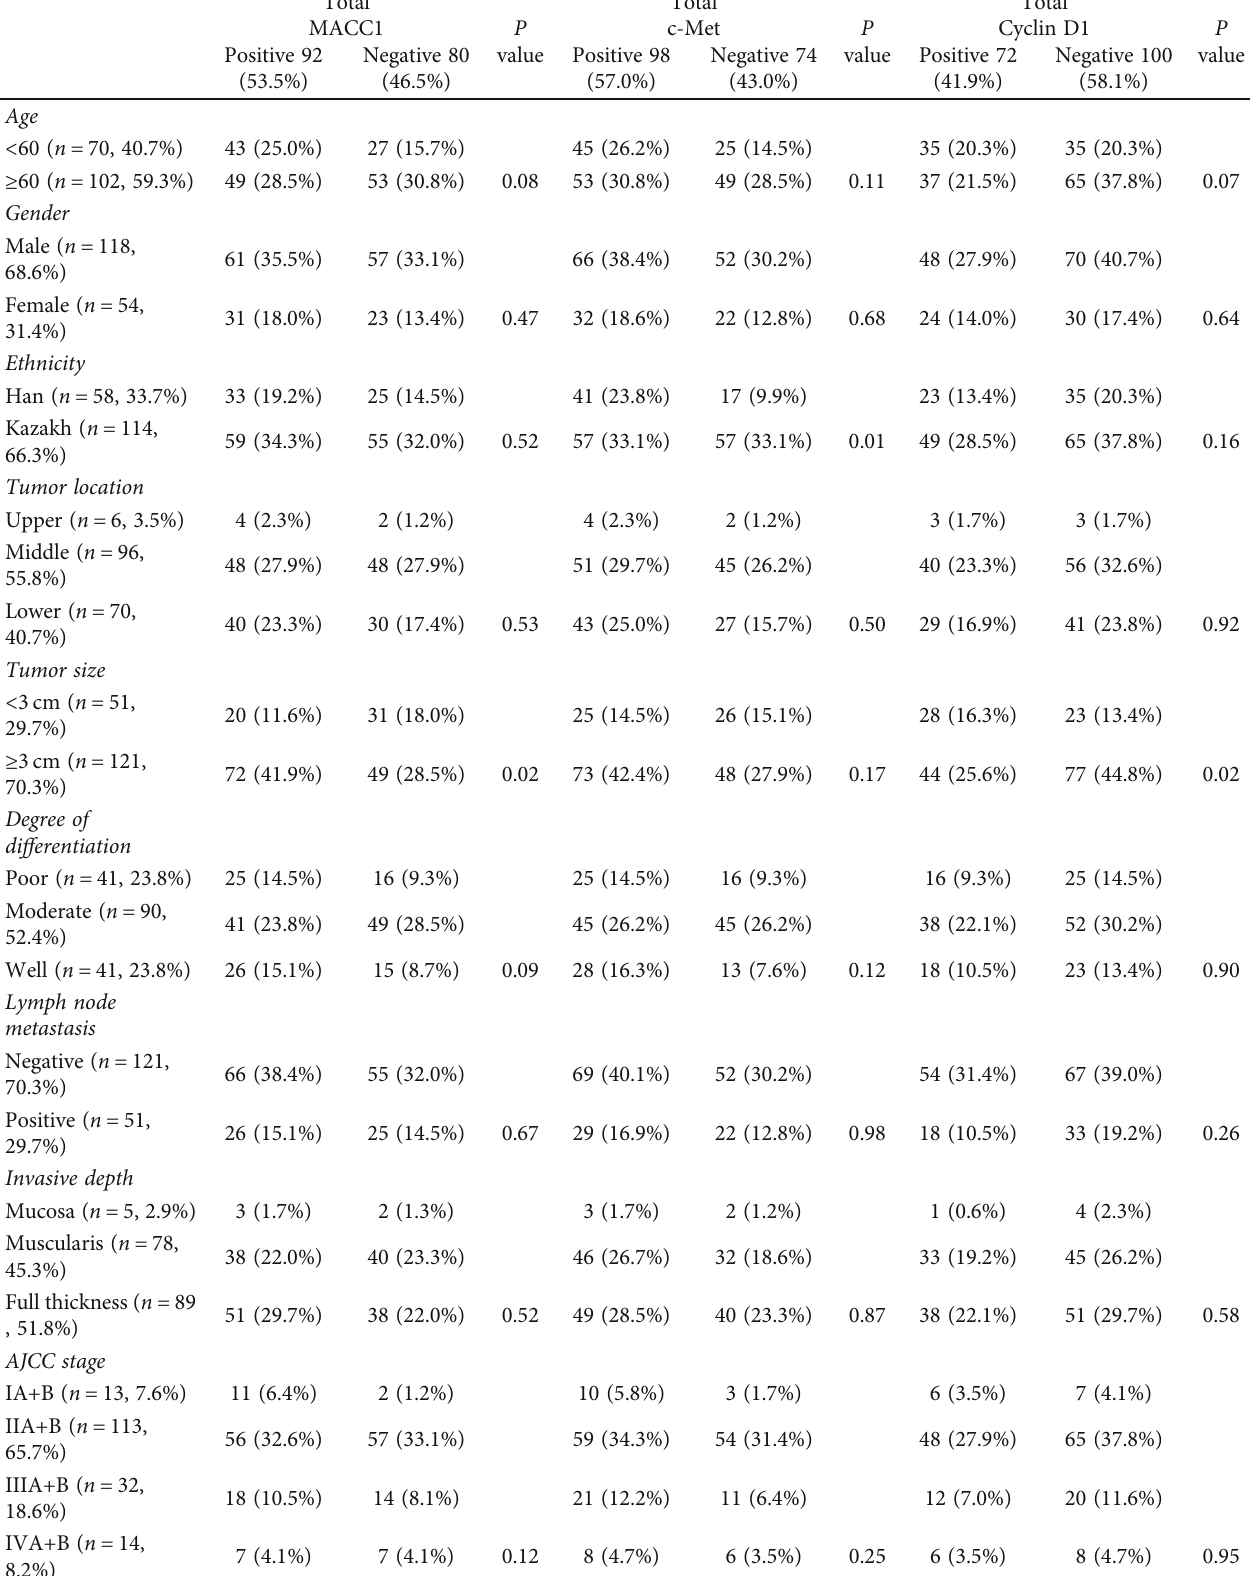
Table 3: Correlation of MACC1, c-Met, and cyclin D1 expression with clinicopathological features in 172 ESCC